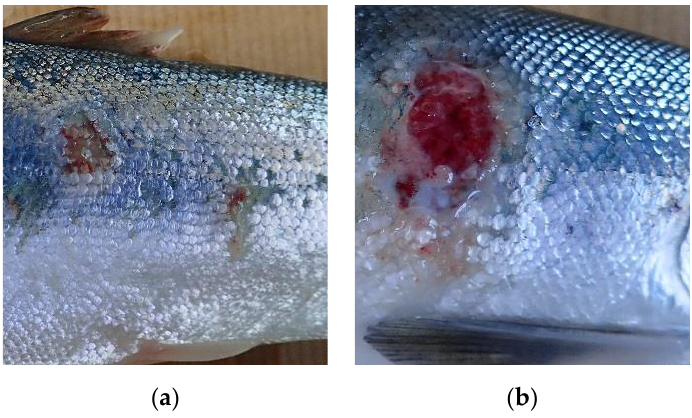
Figure 5. ( a ) Fish with multiple category 1 lesions. ( b ) Fish with one category 2